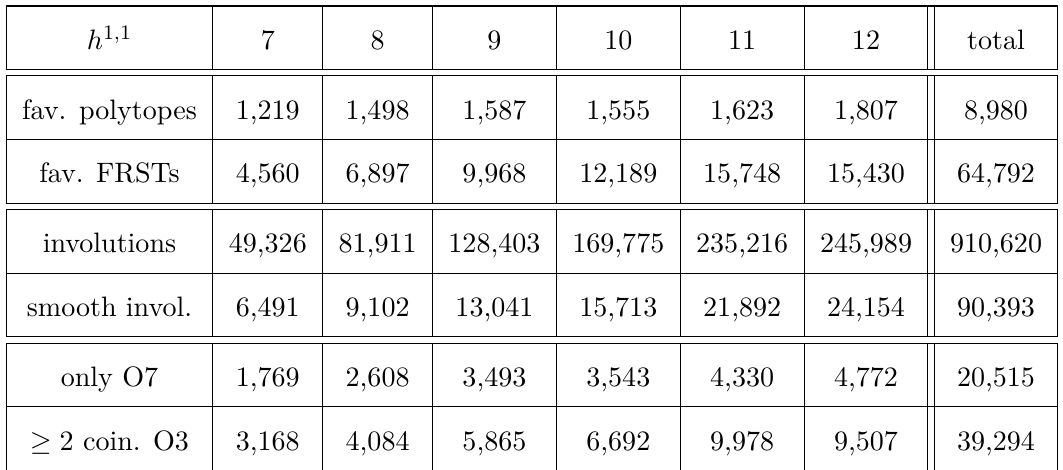
Table 3 . Random FRSTs for favourable polytopes between 7 ≤ h 1 , 1 ≤ 12 . We selected up to 20 polytopes for each combination of Hodge numbers ( h 1 , 1 , h 1 , 2 ) available in the KS database. at the end of section 3.1, we can detect the singular models. We refer to models that do not present manifest pathologies as smooth involutions